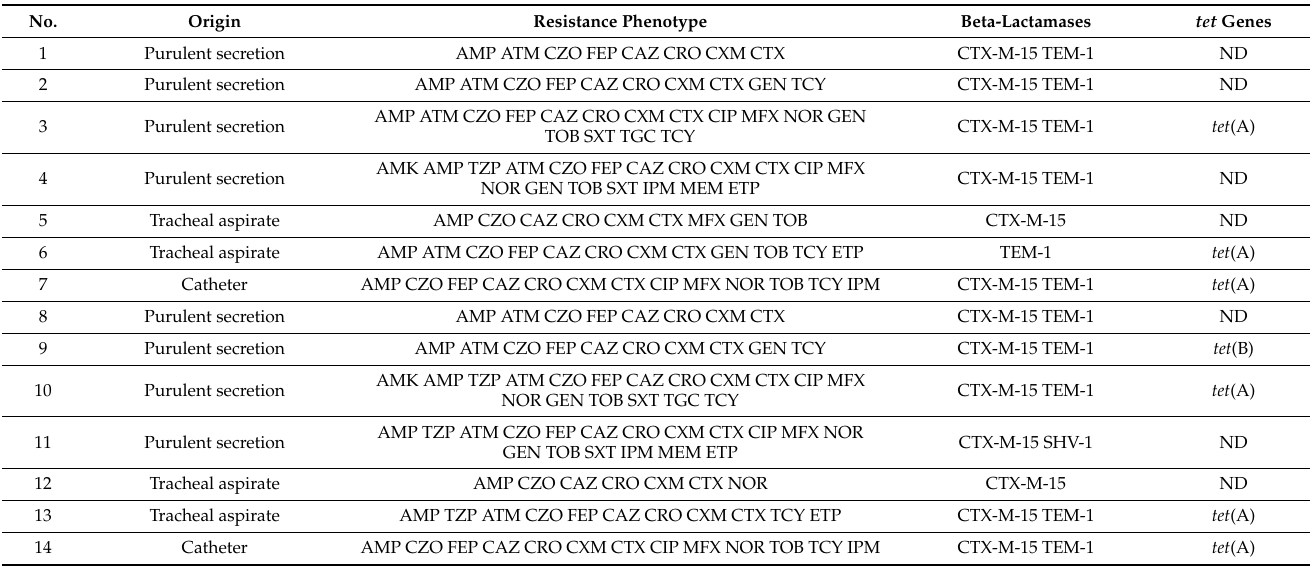
Table 1. Resistance phenotype and associated genotype in the 14 E. coli strains from clinical samples in a Romanian hospital.